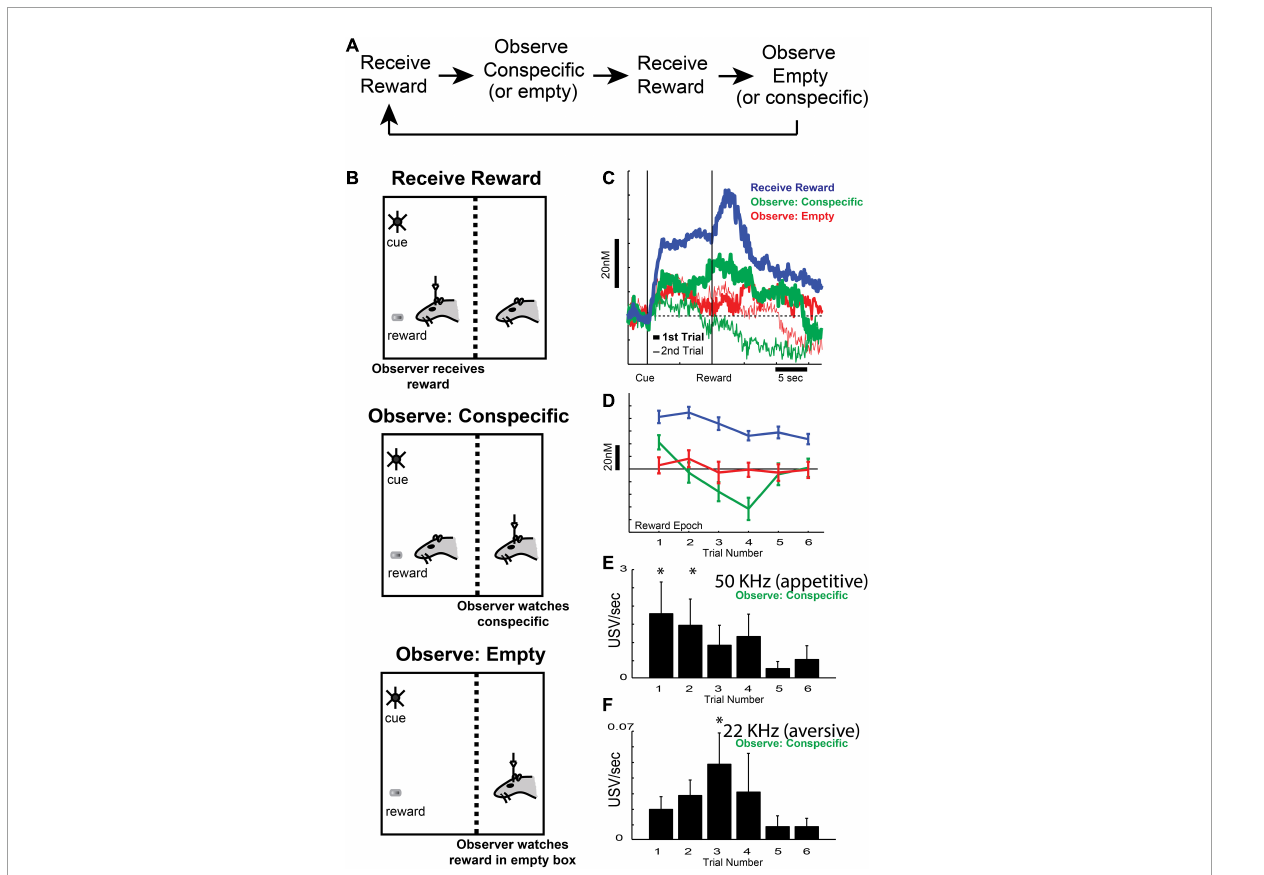
FIGURE3 (A,B) Task design, with an example of the order of blocks within a session. Reward (sucrose pellet) was delivered 10 s following the onset of cue lights. Each session consisted of three block types (B) : (blue: recording rat receives reward, green: recording rat observes conspecific receiving reward, or red: recording rat observes a sucrose pellet being delivered to an empty chamber), with an average of 15 trials per block. Rats were able to observe, smell, and hear the conspecific through a wire mesh. (C) Average dopamine concentration in NAc over time during the first (thick lines) and second (thin lines) trial of each trial type (blue: recording rat receives reward, green: recording rat observes conspecific receiving reward, or red: recording rat observes a sucrose pellet being delivered to an empty chamber). (D) Average dopamine release for all trial types (blue: recording rat receives reward, green: recording rat observes conspecific receiving reward, or red: recording rat observes a sucrose pellet being delivered to an empty chamber) during the reward epoch of the first six trials within the block. (E,F) 50 (E) and 22 kHz (F) ultrasonic vocalization rates for the first six trials during the reward epoch (2 s following reward delivery to the conspecific). Asterisks denote significant difference between indicated trial and the last trial; Wilcoxons, p < 0.05. Adapted from Kashtelyan et al.